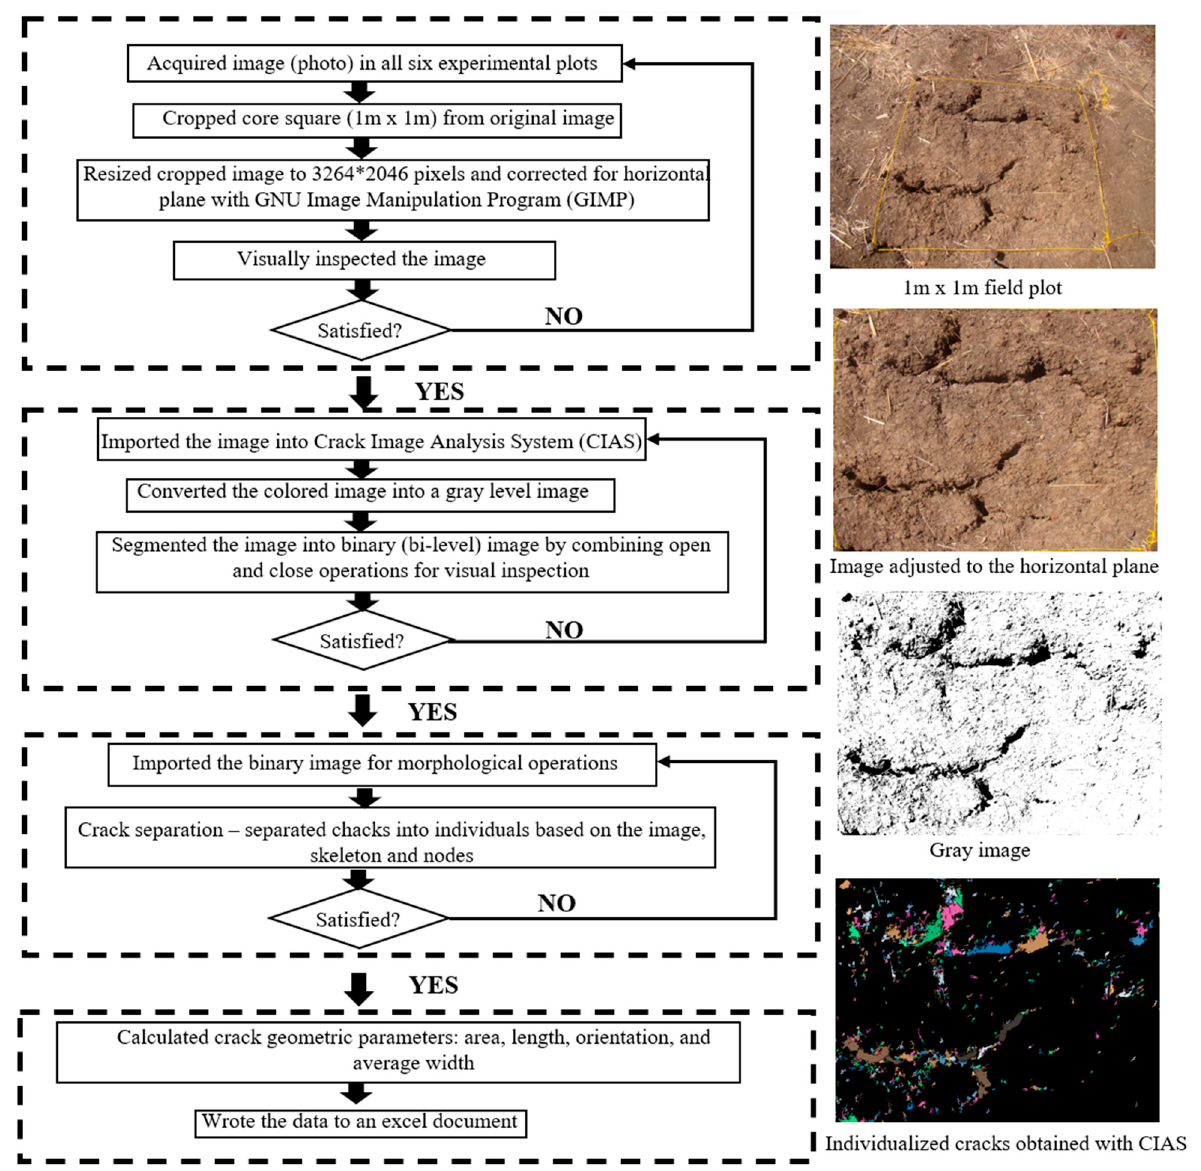
Figure 5. Methodology for image collection, correction and parameter calculation.